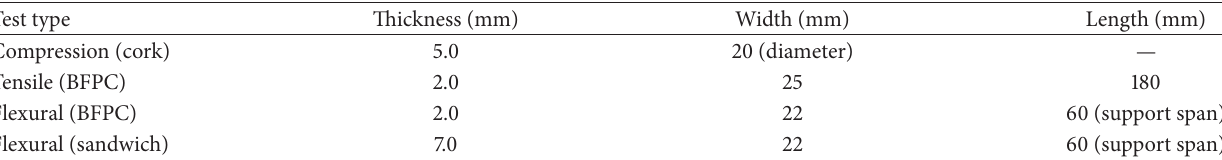
Table 1: Configuration for mechanical tests.